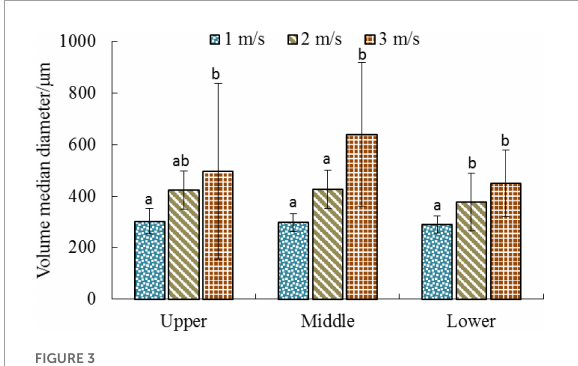
FIGURE3 Comparison of droplet volume median diameter on WPS at three canopy layers. Letters indicate significant differences between flight velocities (Duncan test, α =